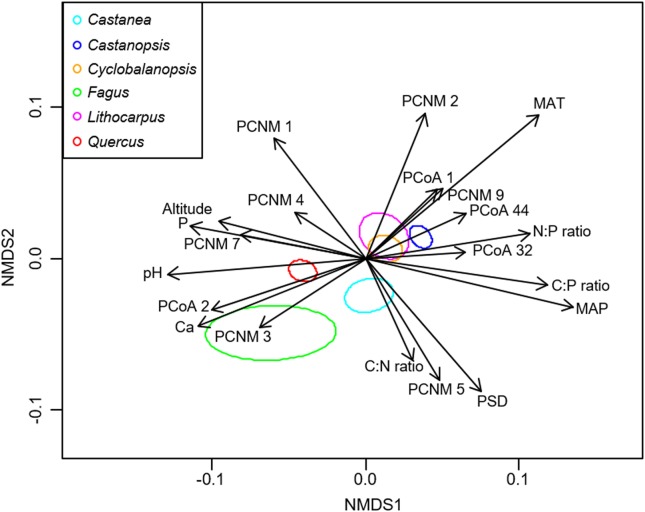
Non-metric multidimensional scaling (NMDS) of the ectomycorrhizal fungal community composition. Significant host and abiotic variables were fitted as vectors onto the NMDS graph (P ≤ 0.001, R2 ≥ 0.05). Ellipses indicate 95% confidence intervals around centroids for each plant genus (stress = 0.208, R2 = 0.207, P < 0.001). C, total soil carbon; N, total soil nitrogen; P, total soil phosphorus; Ca, total soil calcium; PSD, particle size distribution; PCNM, principal coordinates of neighbor matrices. PCoA, principal coordinate analysis of host phylogeny; MAT, mean annual temperature; MAP, mean annual precipitation.